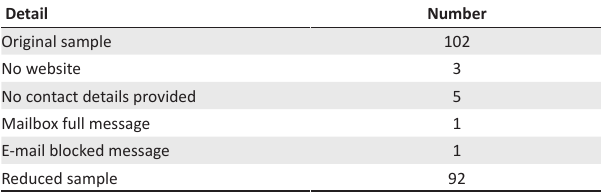
TABLE 1: Summary of the original and reduced sample size. Detail